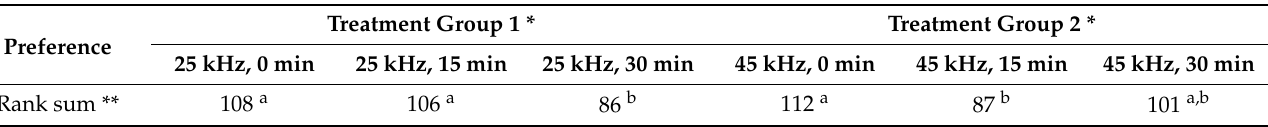
Table 4. Effect of the application of ultrasound at 25 or 45 kHz for 0, 15, or 30 min on the preference- ranking test for Oaxaca cheese (rank